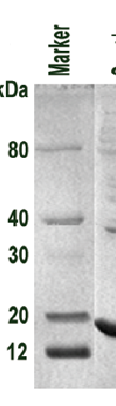
Figure 3. Purification optimization of His- FIP-fve fusion protein. The optimized lysis method of recombinant E. coli electrophoresed by 12% SDS-PAGE; ultrasonic lysis after lysozyme (Son+Lys) and lysozyme (Lys) methods of E. coli with a molecular weight marker. A sample of 3.75 μ L of lysis plus 1.25 μ L 4× Protein Gel Loading Buffer was used in SDS-PAGE.